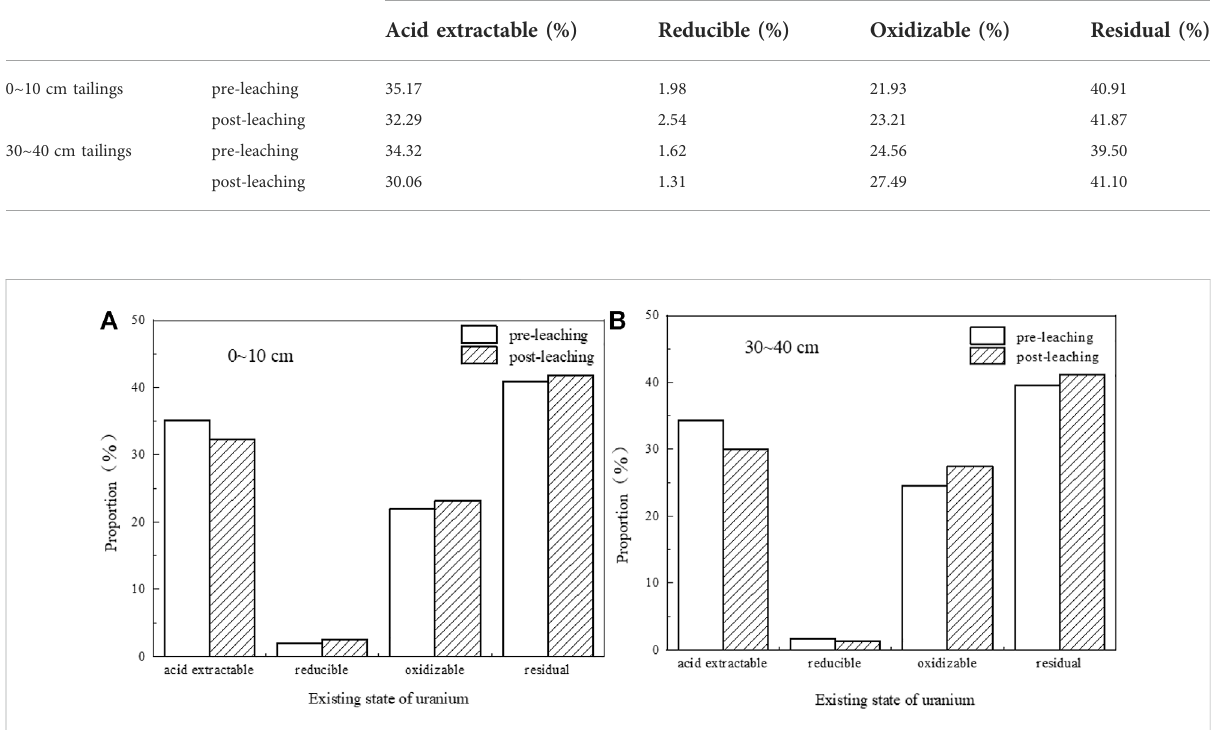
FIGURE 14 Speciation distribution of uranium in tailings before and after leaching. (A) 0 – 10 cm; (B) 30 – 40